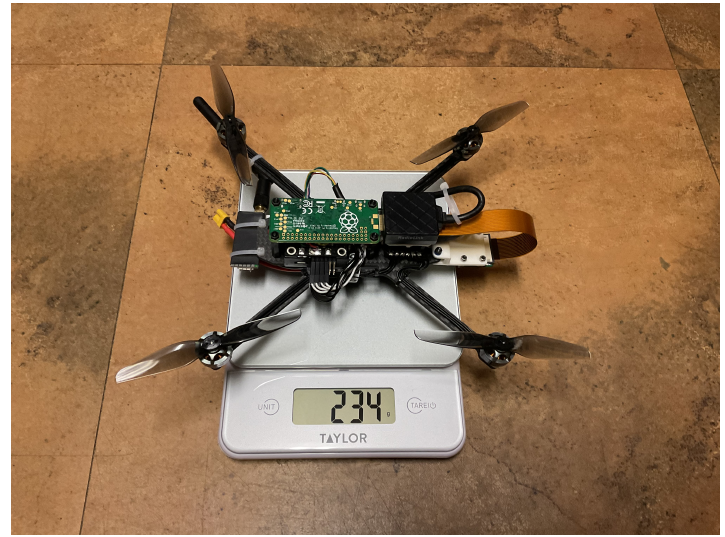
Figure 4. Our small, low-cost drone which weighs under 250